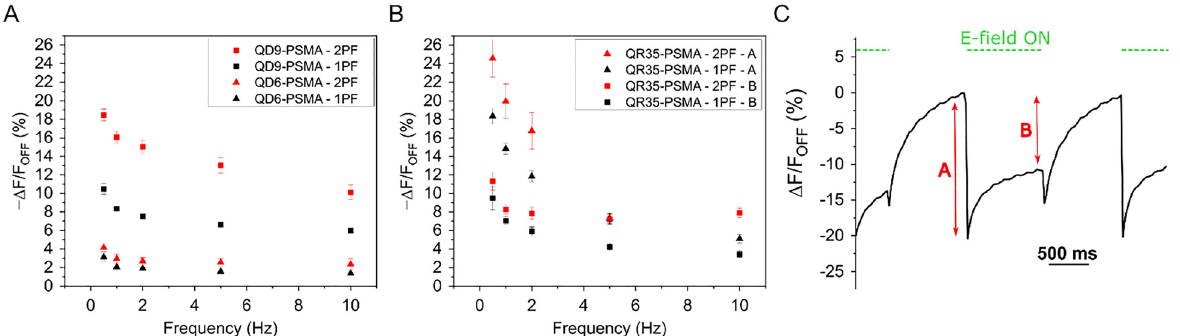
Figure7: (A) Δ F / F OFF as afunctionof the frequency of theappliedelectric fi eldforthetype-IQD6-PSMAandthe quasi-type-II QD9-PSMAunder 1Pexcitation(460 – 495nm,black)and2Pexcitation(900nm,red).(B) Δ F / F OFF asafunctionofthefrequencyforthequasi-type-IIQR35-PSMAat both locations indicated in the 0.5 Hz – 150 kV/cm modulated fl uorescence trace shown in panel